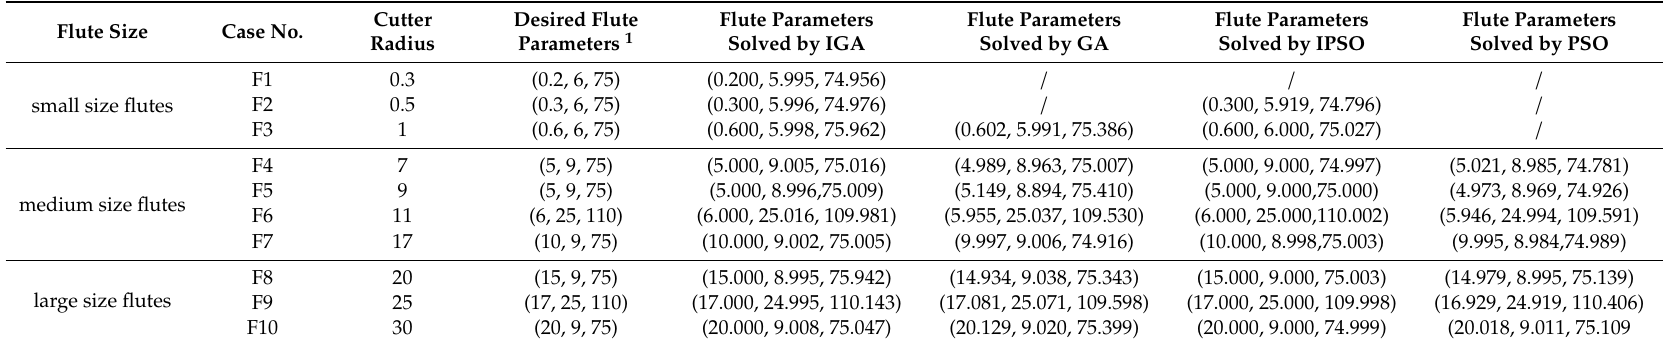
Table 4. Initial setting parameters of grinding wheels calculated by IGA .